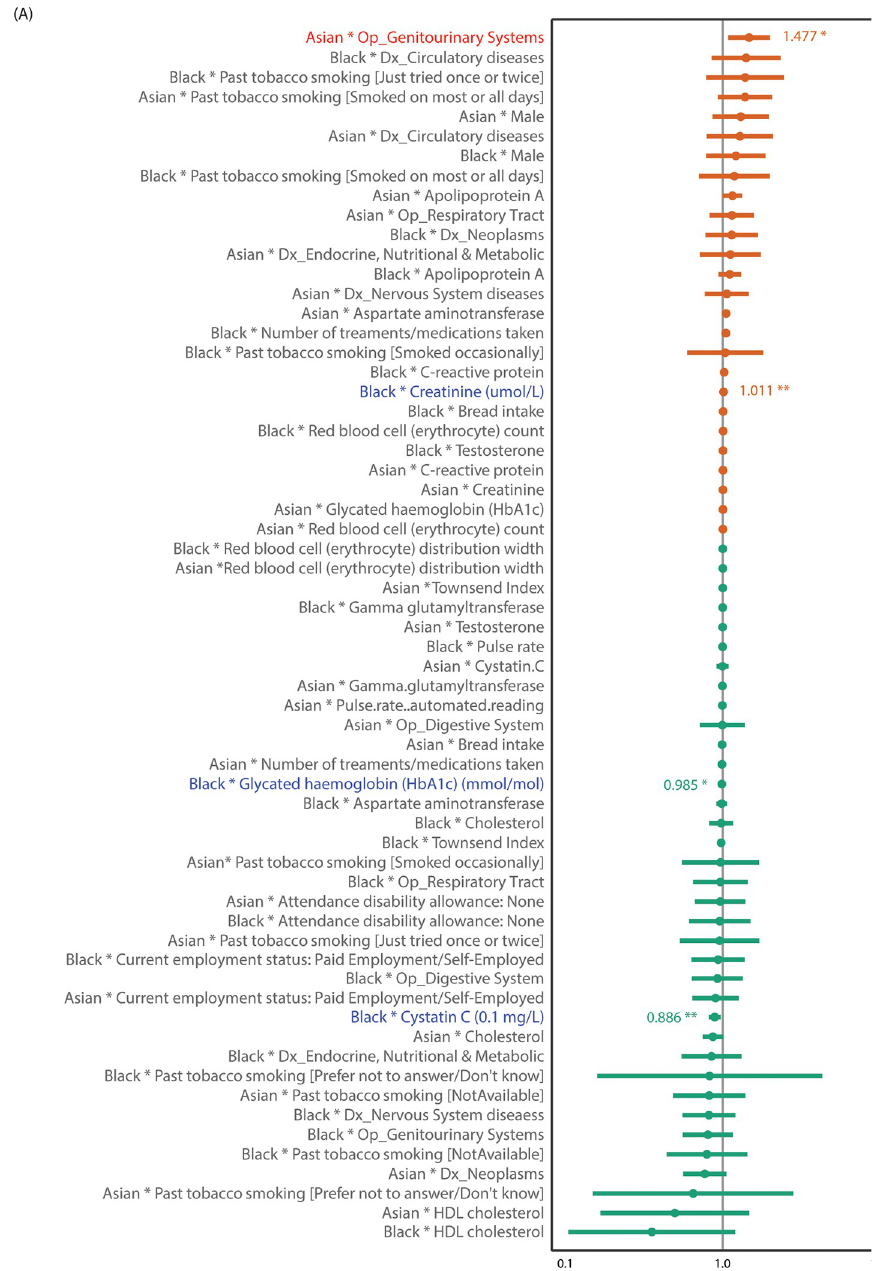
Fig 4. Risk factor interactions with ethnicity on overall mortality. Forest plots showing HR and 95% CI bars of ethnicity-by-risk-factor interactions tested in the two pooled sample survival models combining Whites, Blacks, and Asians for overall (all-cause) mortality. Significant interactions with Blacks (blue) and Asians (red) are highlighted with stars showing significant level ( � for < 0.05; �� for < 0.01). Mortality risk factor interactions with ethnicity. Two pooled-sample multivariable sur- vival models were tested for interactions between Asian and Black ethnic groups and 31 all- cause mortality risk factors (Fig 4) and 15 digestive cancer mortality risk factors (Fig 5). For all-cause mortality, there was one significant interaction between Asian ethnicity and